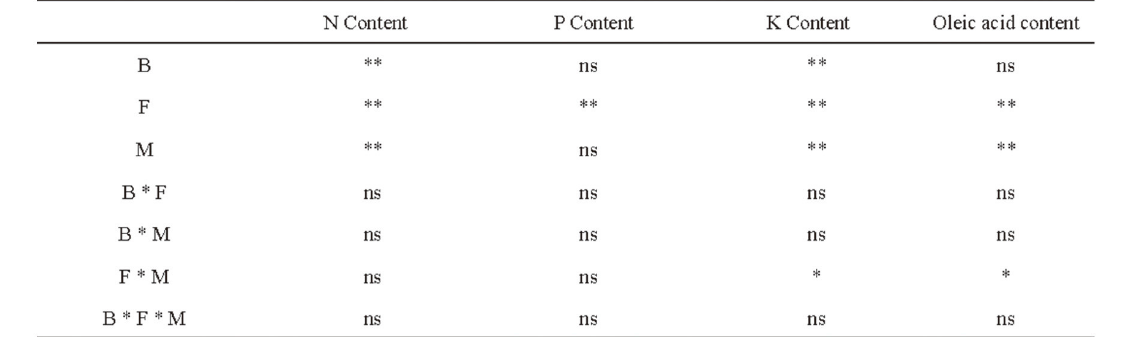
FIGURE1 Effects of biochar, inorganic fertilizer and organic fertilizer on pod nutrition at flowering stage (A–C) and seed oleic acid content at mature stage (D) . Bars followed by the same letter are not significantly different according to LSD-test ( P ≤ 0.05). Bars represent standard errors of the means. * and ** Significant difference at p = 0.05 and p = 0.01, respectively, and ns indicates no significant